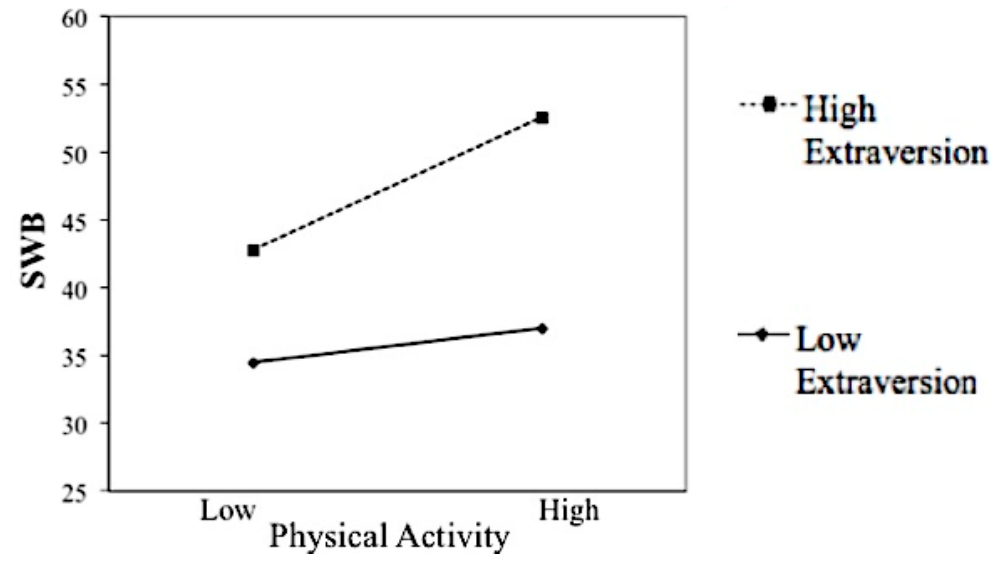
Figure 1. Extraversion’s moderation of the relationship between physical activity and SWB.